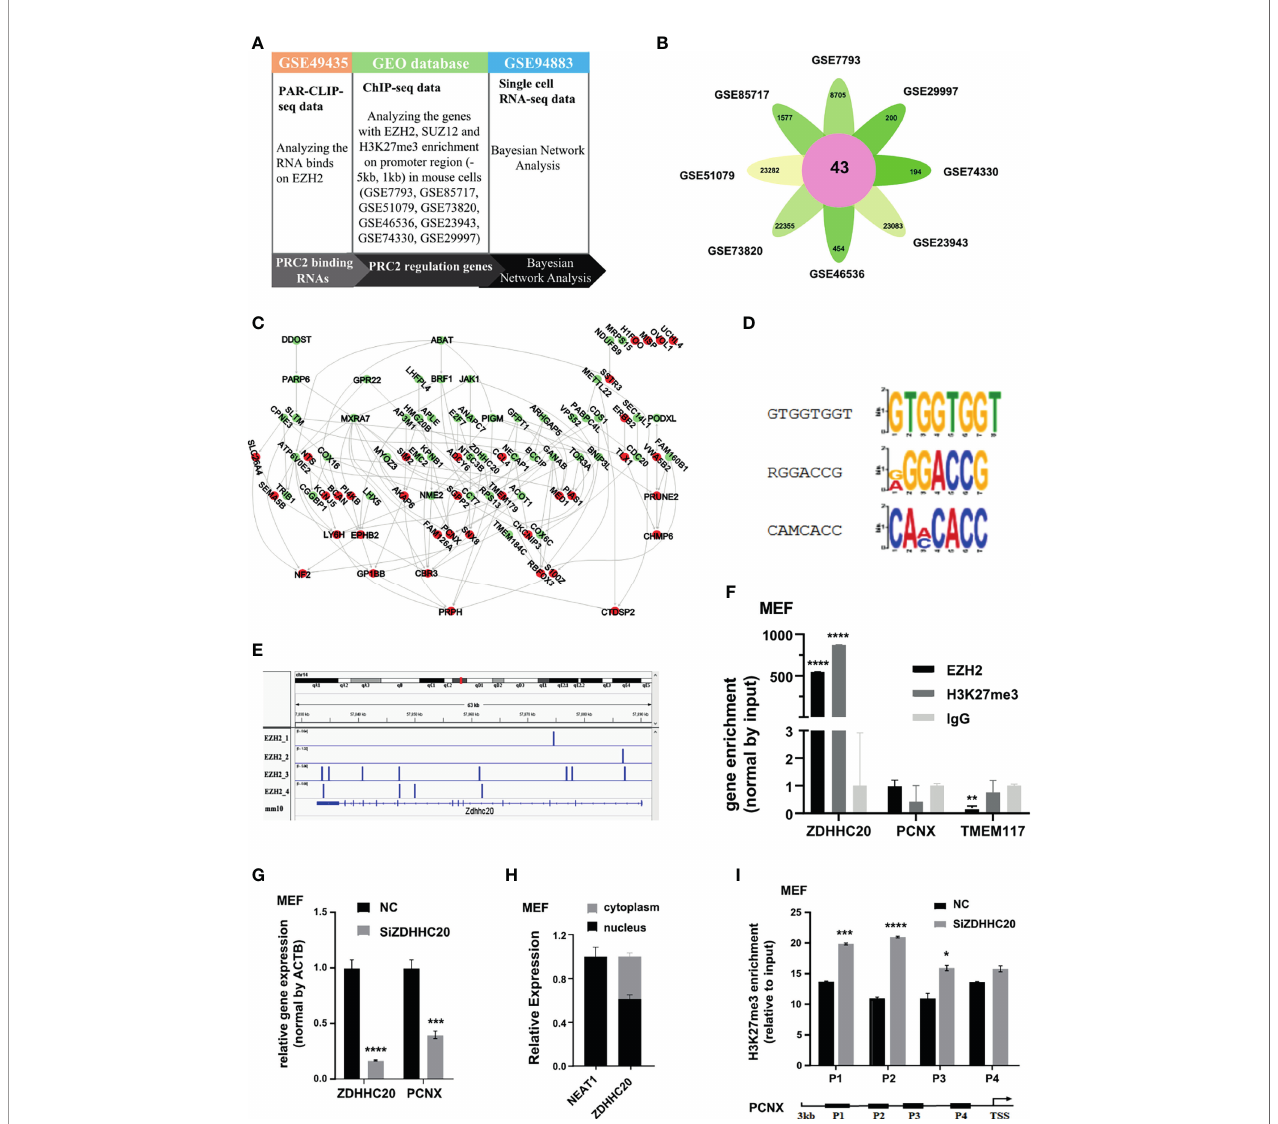
FIGURE 7 | PRC2 binding RNAs regulate histone methylation in mouse. (A) The work fl ow of Bayesian network analysis of panel (B) . (B) Genes with EZH2, SUZ12, and H3K27me3 enrichment on their promoter region ( − 5 kb, +1 kb) in eight ChIP-seq data. (C) The Bayesian gene regulatory network analyzing the regulatory relationship between PRC2-bound RNAs and PRC2-regulated genes in mouse. (D) Analysis of the enrichment of three RNA recognition motifs of EZH2 protein in par-CLIP-seq data of EZH2 (GSE49435) using MEME algorithm. (E) Four repeats of EZH2 par-CLIP-seq data (GSE67963) reveal that EZH2 binds to the RNA of ZDHHC20 in mice. (F) RIP assay analyzing the RNA of ZDHHC20 binding to EZH2 protein and histone H3 with tri-methylation of lysine 27 in MEF cells, with TMEM117, PCNX, and IgG as negative control (n = 3). (G) qRT-PCR detecting the mRNA expression of PCNX in MEF cells transfected with siZDHHC20 for 48 h (n = 3). (H) The distribution of ZDHHC20 in the cytoplasm and nucleus, with NEAT1 is used as a control (n = 3). (I) ChIP assay analyzing the enrichment of H3K27me3 on the PCNX promoter in MEF cells transfected with siZDHHC20 for 48 h (n = 3). Data are represented as means ± SD, * p < 0.05, *** p <